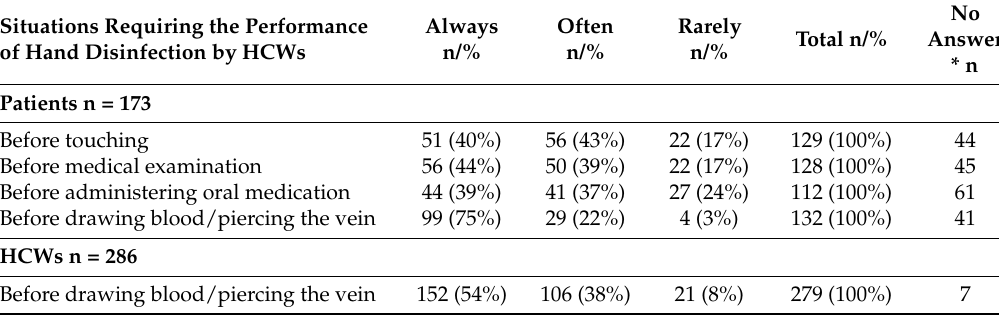
Table 3. Summary of the answers of patients and HCWs arising from the question: How often did HCWs perform HH before first contact, touching you, medical examination, administering oral medication, or piercing a